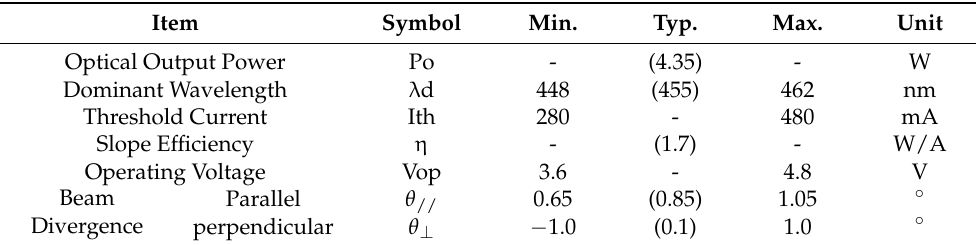
Table 1. Blue LD electrical and optical characteristics (Tc = 25 ◦ C, I f = 3.0 A, CW operation).